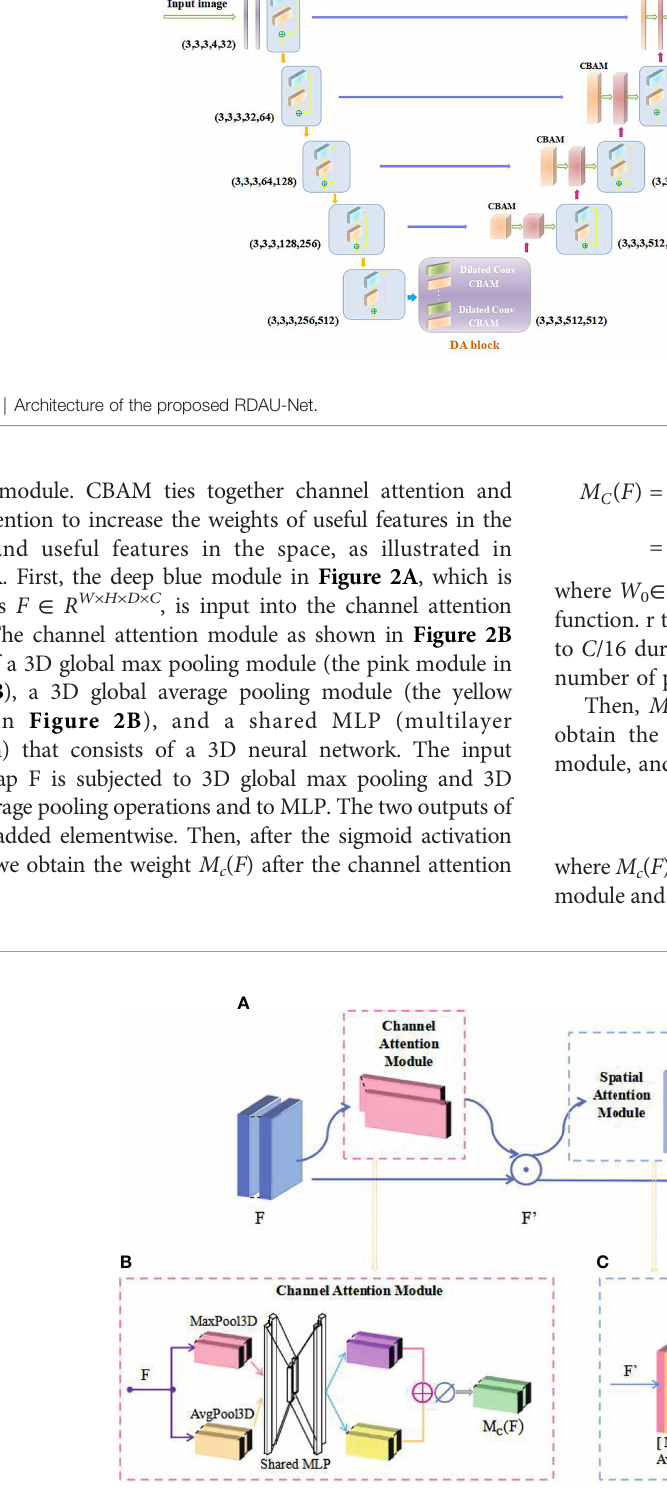
FIGURE 2 | Structure of a 3D CBAM block. (A) The overview of 3D CBAM; (B) Structure of the Channel Attention Module; (C) Structure of the Spatial Attention